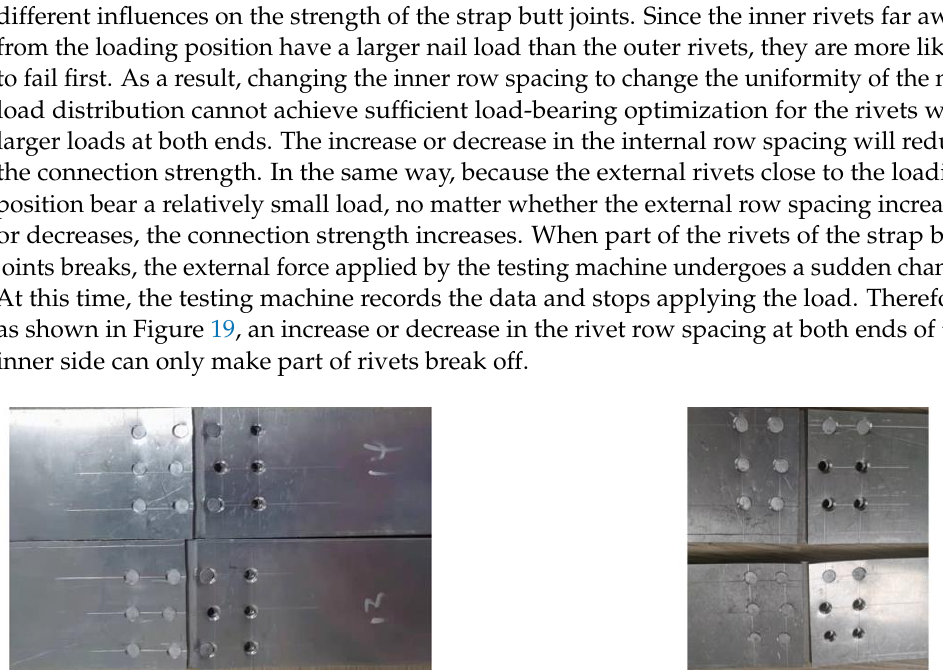
Figure 18. Comparison of failure modes of the simulation and experiment: ( a ) simulation results; ( b ) experimental results; ( c ) rivet shear failure results.